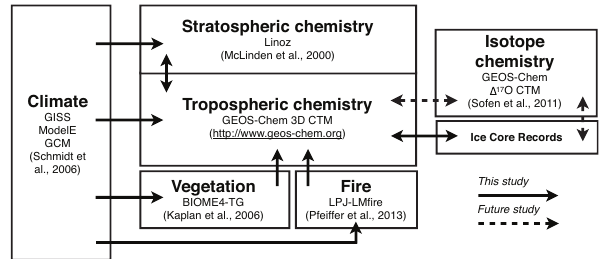
Fig. 1. The ICE age Chemistry And Proxies (ICECAP) framework. Each box represents a separate model or measurement, except for stratospheric and tropospheric chemistry, which are online together in GEOS-Chem. Arrows indicate the coupling between models and measurements as used in this study. Dashed arrows indicate future